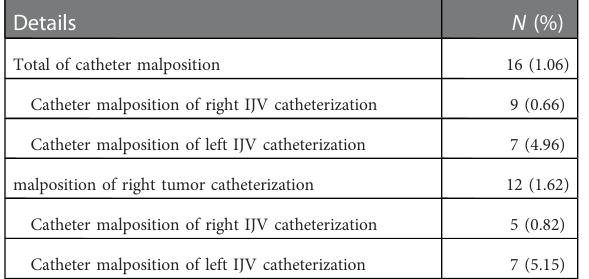
TABLE 3 Catheter malposition